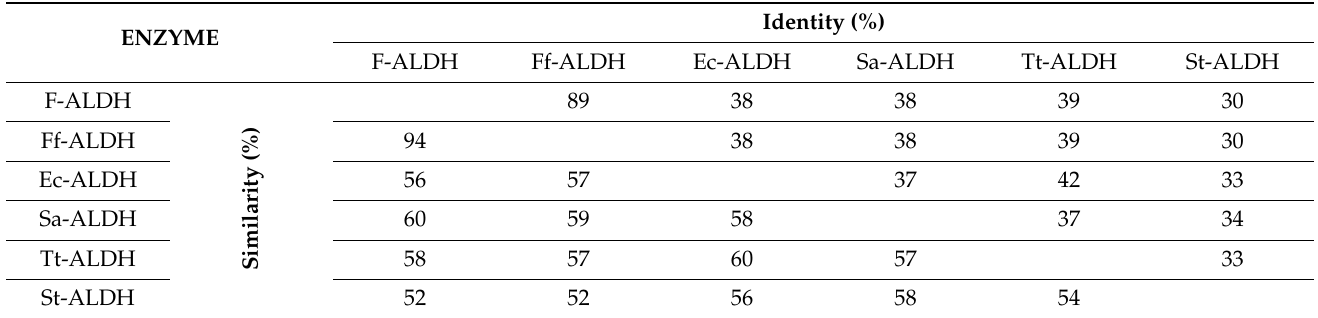
Table 1. F-ALDH sequence similarity of F-ALDH to aldehyde